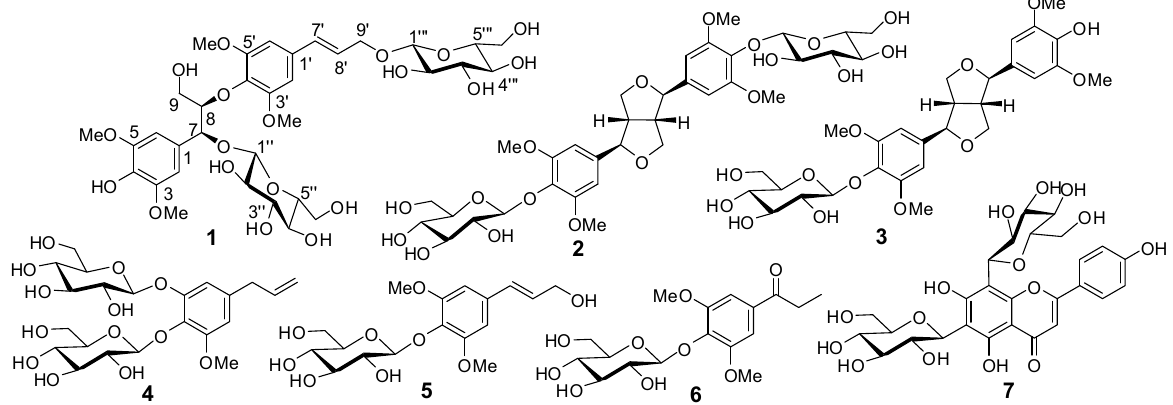
Figure 1. Structures of compounds 1 – 7